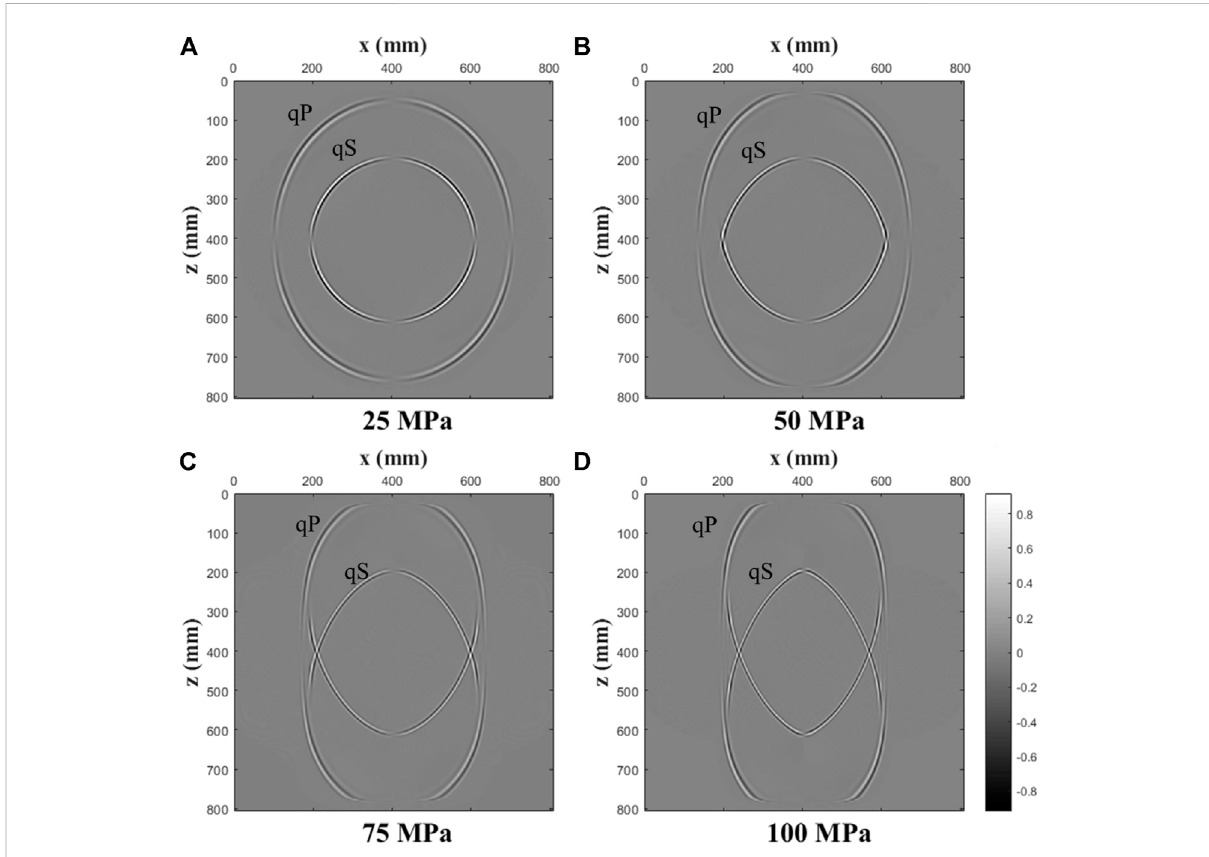
FIGURE 11 Coupled wave fi eld snapshots of the x-component of the particle velocity at t = 0.1 ms for various pure shear stresses ( (A) : 25 MPa; (B) : 50 MPa; (C) : 75 MPa; (D) : 100